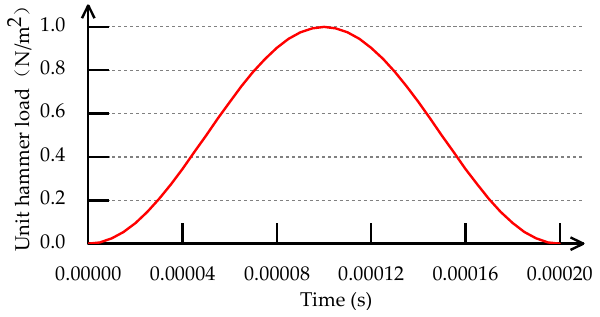
Figure 2. The curve of unit hammer load versus time.